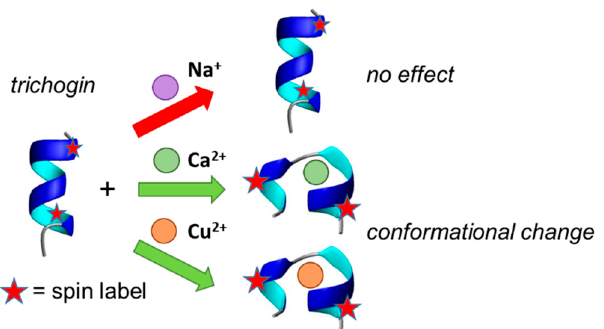
Figure 4. Schematic models built from literature data [33,34] and calculations [73] for ion–peptide interactions, explaining the longer distance between the two spin labels in the presence of Ca(II) or Cu(II) ions, in respect to the peptide alone, or with Na(I).